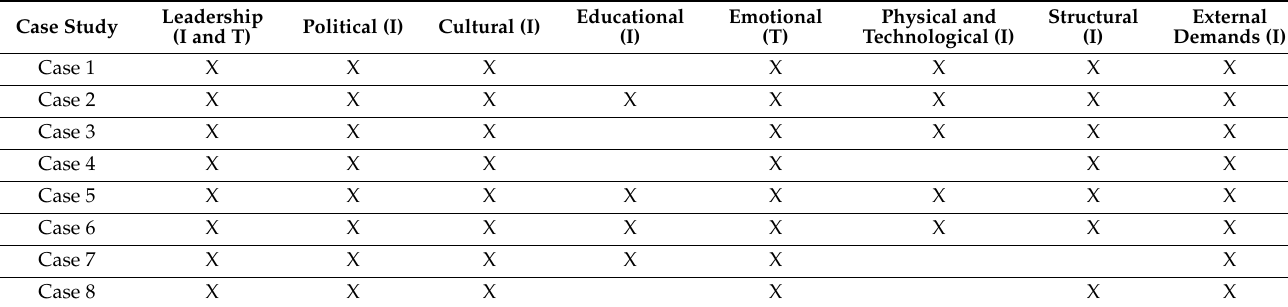
Table 4. QUASER coding identified by